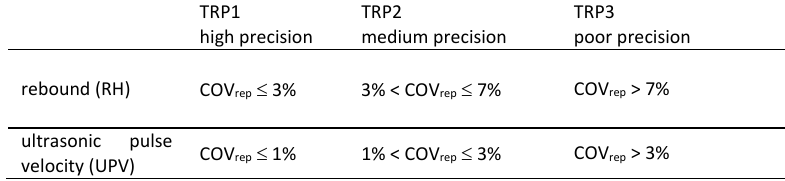
Table 2. Definition of the TRP classes (COV rep = coefficient of variation for repeatability of test